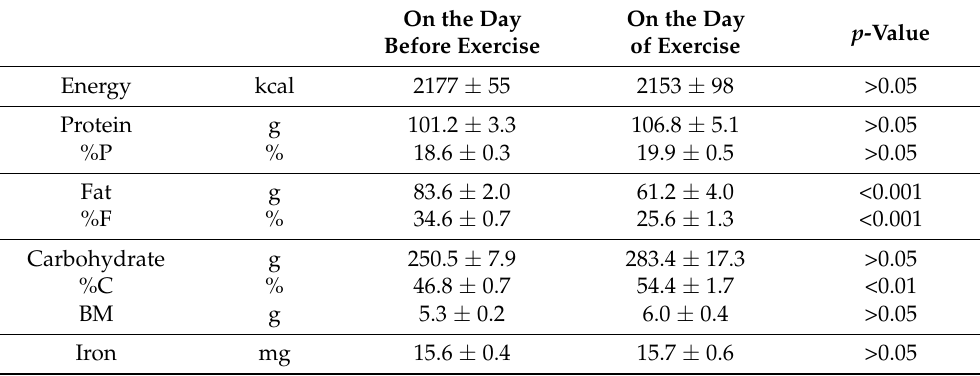
Table 1. Comparisons of nutritional intake on the day before exercise and day of exercise.